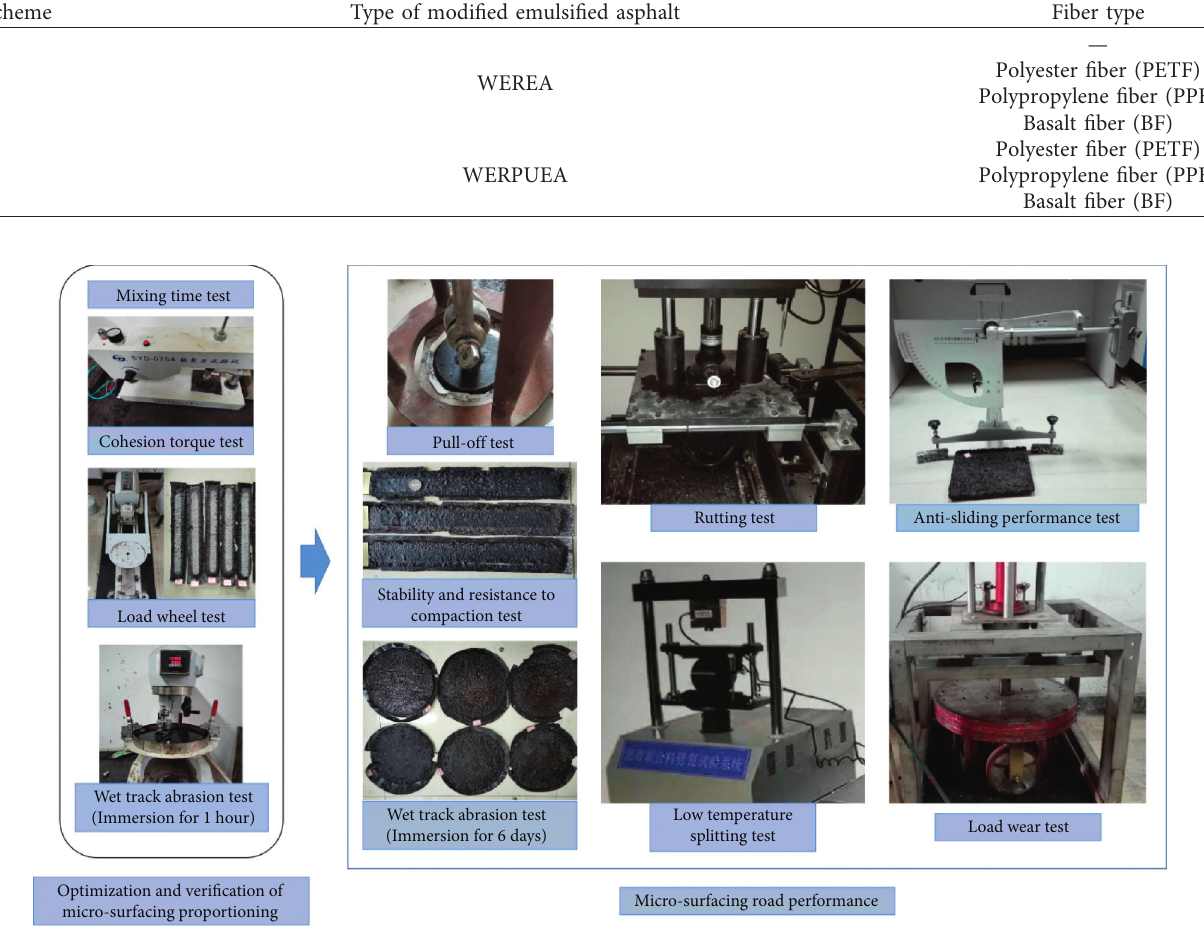
Figure 1: Microsurfacing performance test.